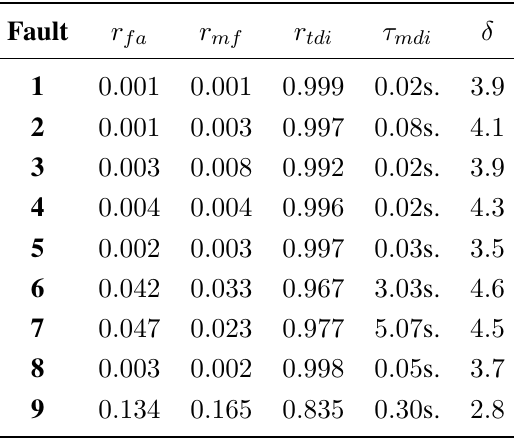
Table 8. Monte Carlo analysis with δ of Equations